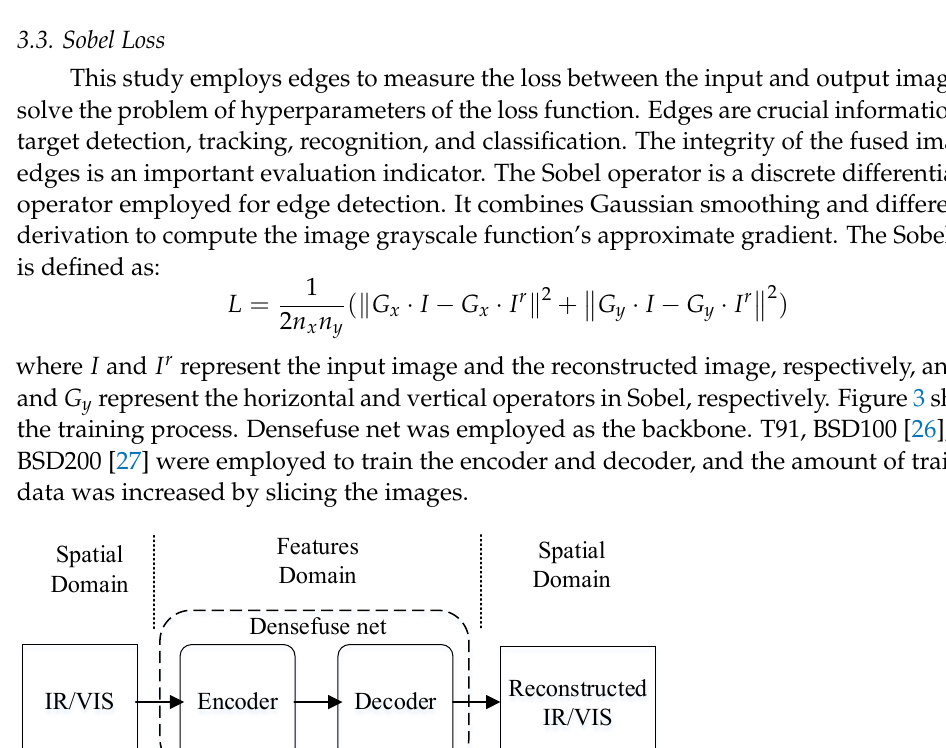
values were in a reasonable range.